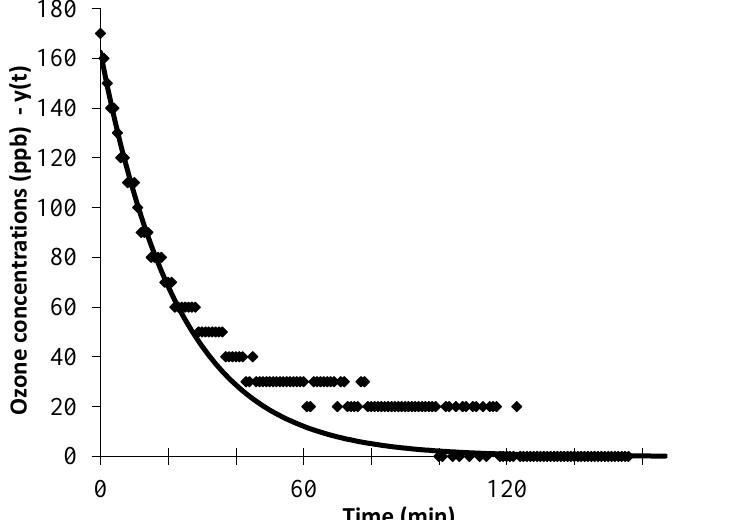
Figure 1. Half-life curve of ozone decay in the test room. A least squares regression method was used to fit experimental data.